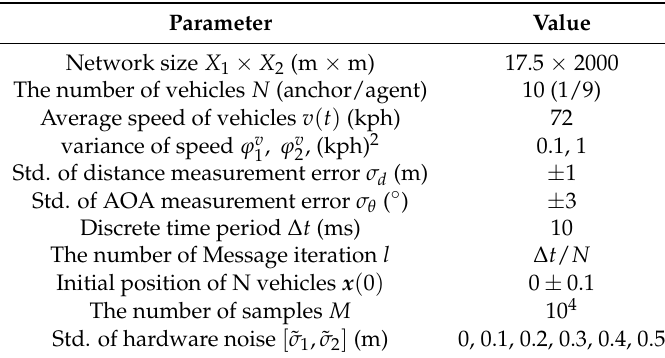
Table 1. Simulation